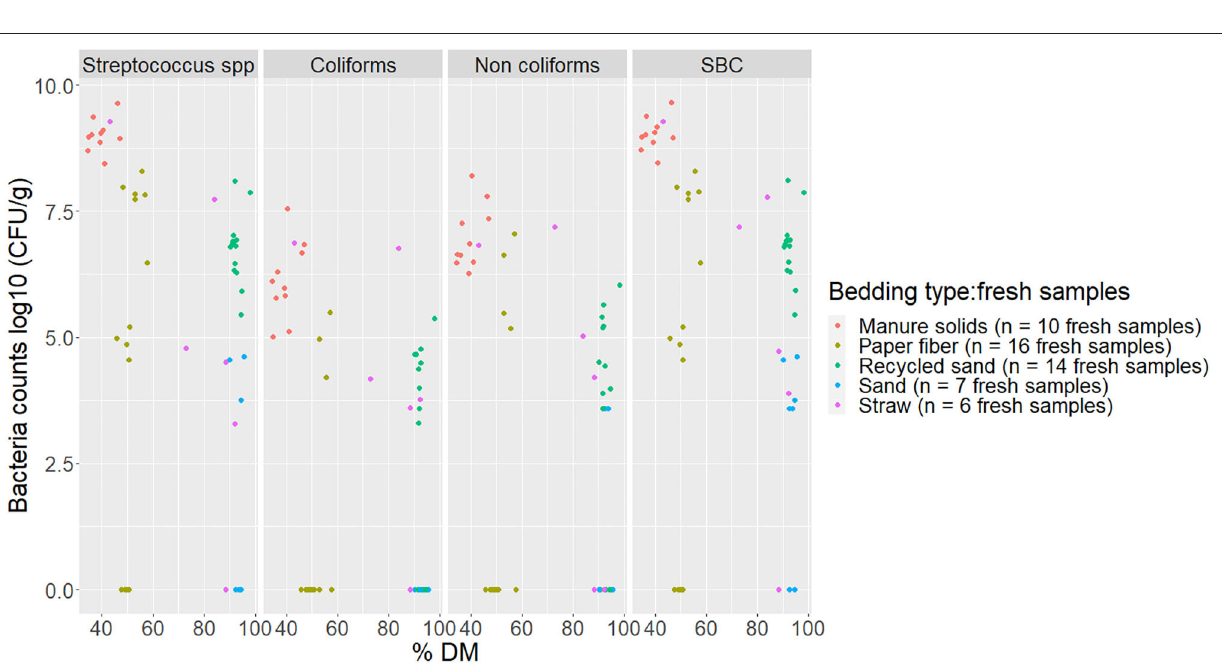
a specific outcome and when using only a few samples from a specific point in time in an attempt to describe bedding